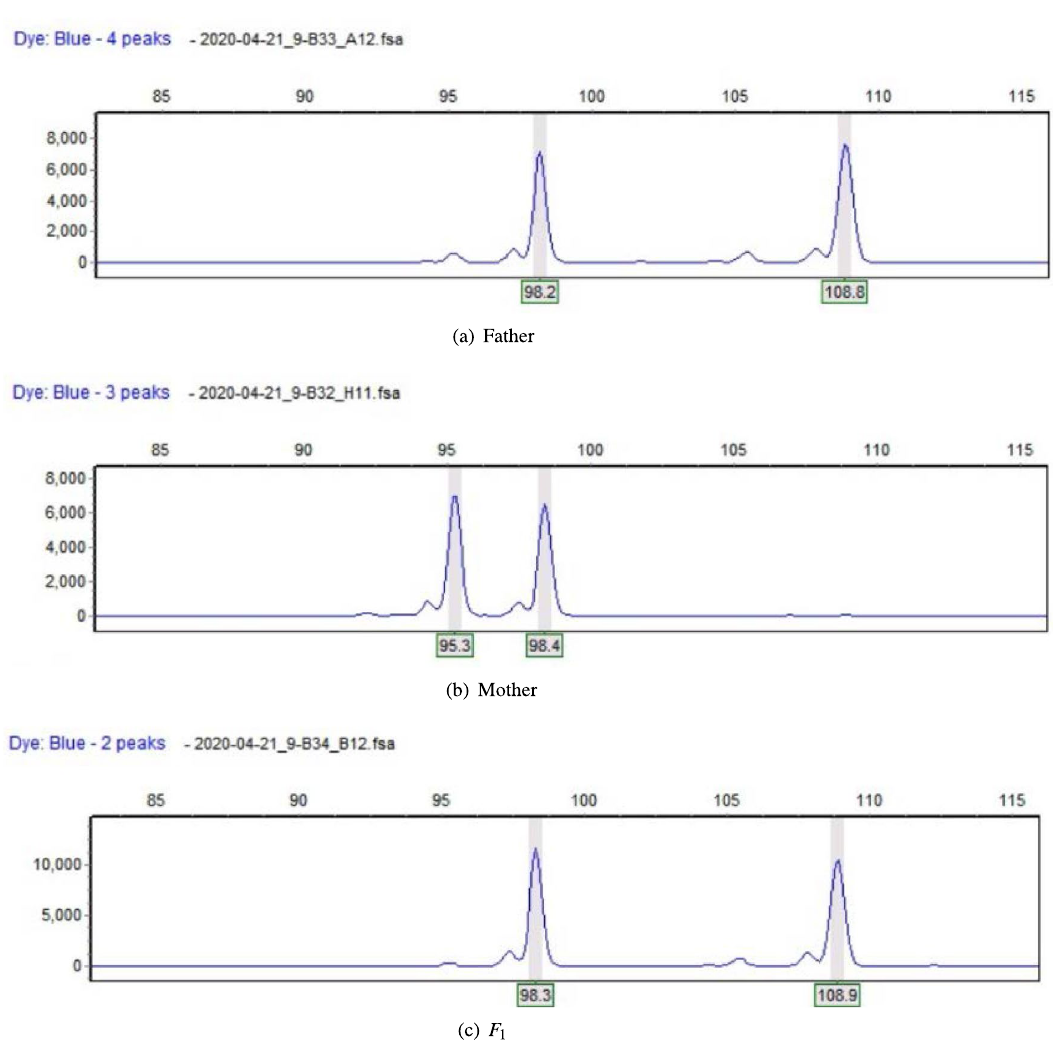
Figure 2. The paternal type.Peak value represents segment